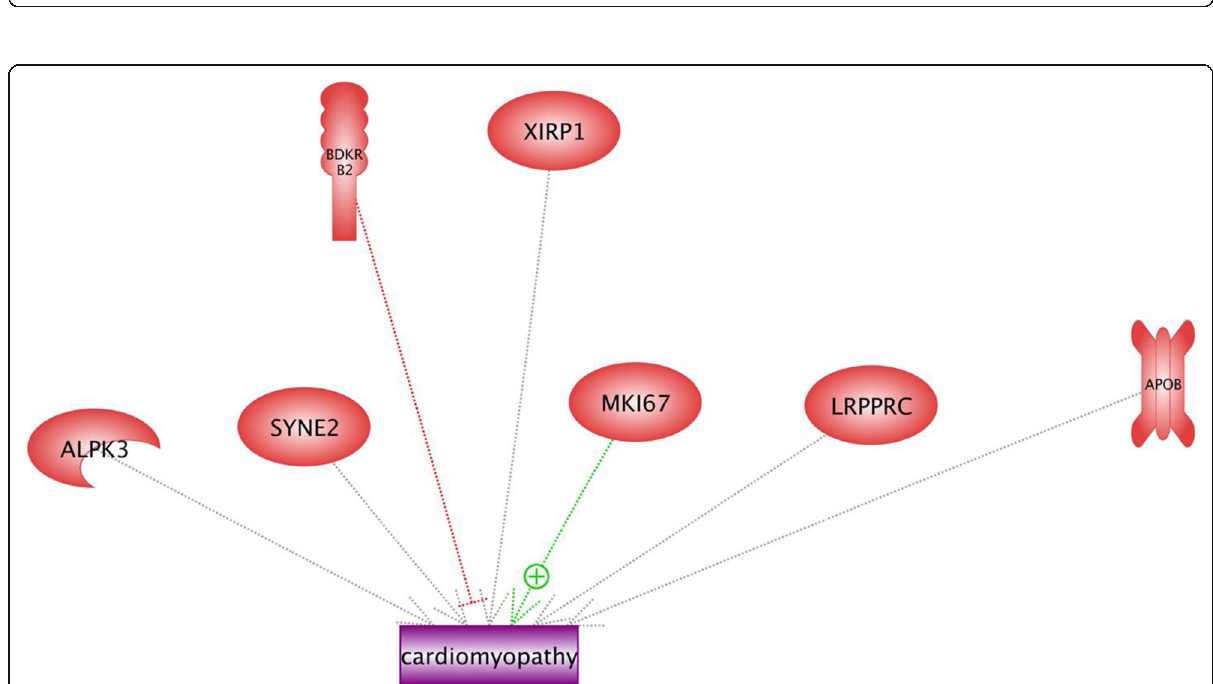
Fig. 12 Identification of regulatory roles of candidate genes in metastasis under hypoxia condition. We found that PRKDC , CD200 , SYTL2 , and BDKRB2 enhanced the metastasis event. PRKDC encodes DNA-PKcs protein that participates in the development of the immune system and is usually overexpressed in cancer metastasis. SYTL2 (synaptotagmin like 2) is one of the members of C2 domain-containing protein family. It is demonstrated that SYTL2 contributes in ovarian cancer and its overexpressed one can promote the metastatic potential in ovarian cancer. Immunoglobulin superfamily (IgSF) contains two domains including CD200 and CD200 -R, and their interaction is also involved in functions of myeloid cells. The overexpression of CD200 in breast cancer can be considered as an important risk factor for metastasis. Bradykinin contains nine amino acid peptide chains and is implicated in many responses including vasodilation, edema, smooth muscle spasm, and pain fiber stimulation